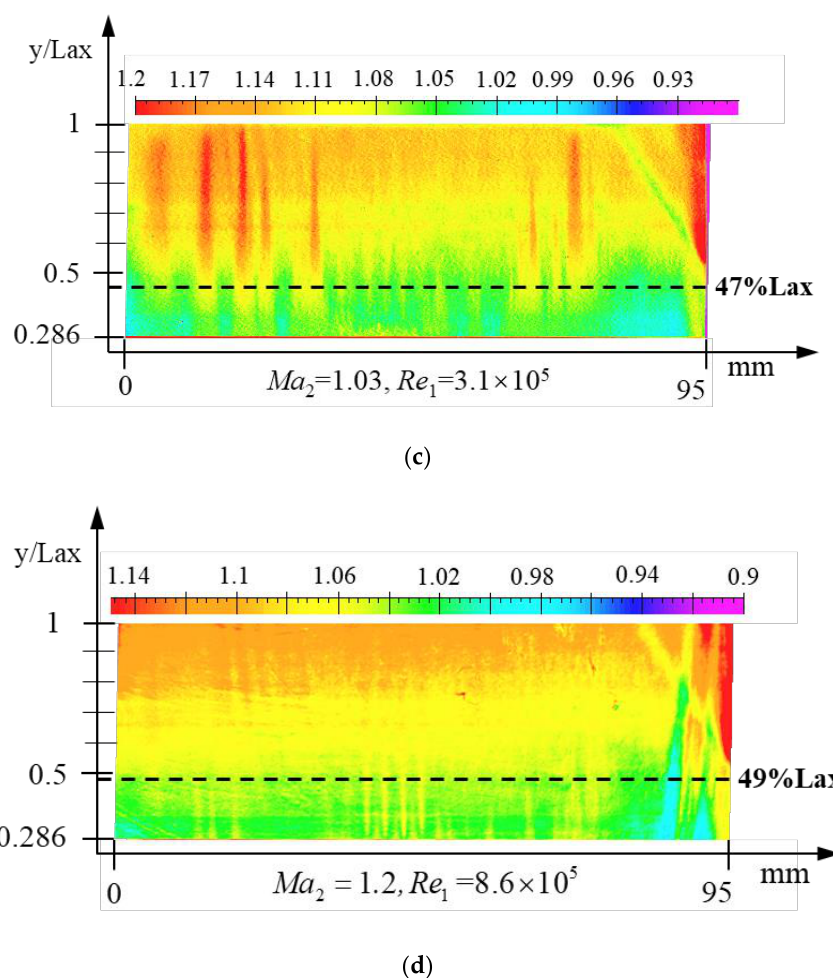
Figure 4. Transitional location measurement results.